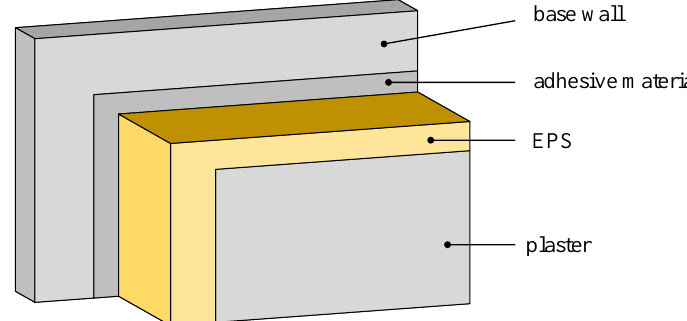
Figure 1. Base wall with EPS plaster.